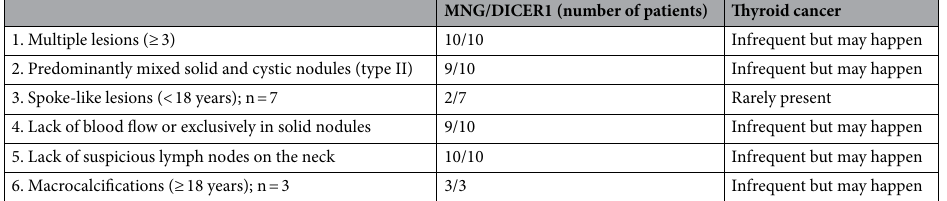
Table 3. Characteristic features of MNG in DICER1 syndrome and their presence in thyroid cancer (n = 10; 7 < 18 years and 3 ≥ 18